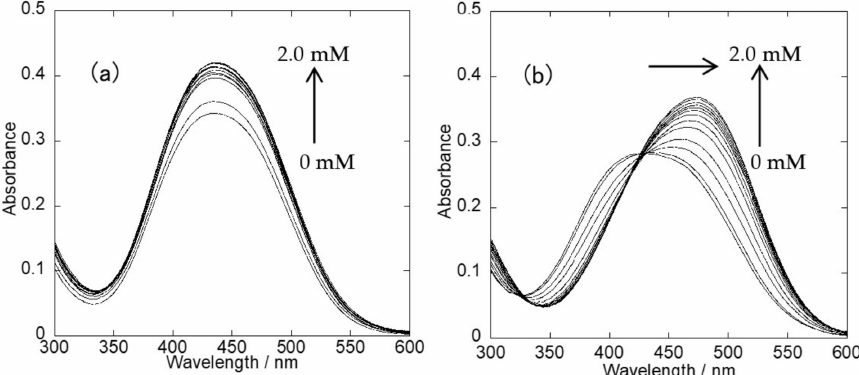
Figure 3. Changes in UV-Vis spectra of 1-Zn in the ( a ) absence or ( b ) presence of ATP with increasing concentrations of 3-NH 2 - γ -CyD. [ 1-Zn ] = 0.020 mM; [HEPES] = 5 mM; [ATP] = 2.0 mM; [3-NH 2 - γ - CyD] = 0, 0.020, 0.20, 0.40, 0.60, 0.80, 1.0, 1.2, 1.4, 1.6, 1.8, 2.0 mM, in 1% DMSO aq. at pH